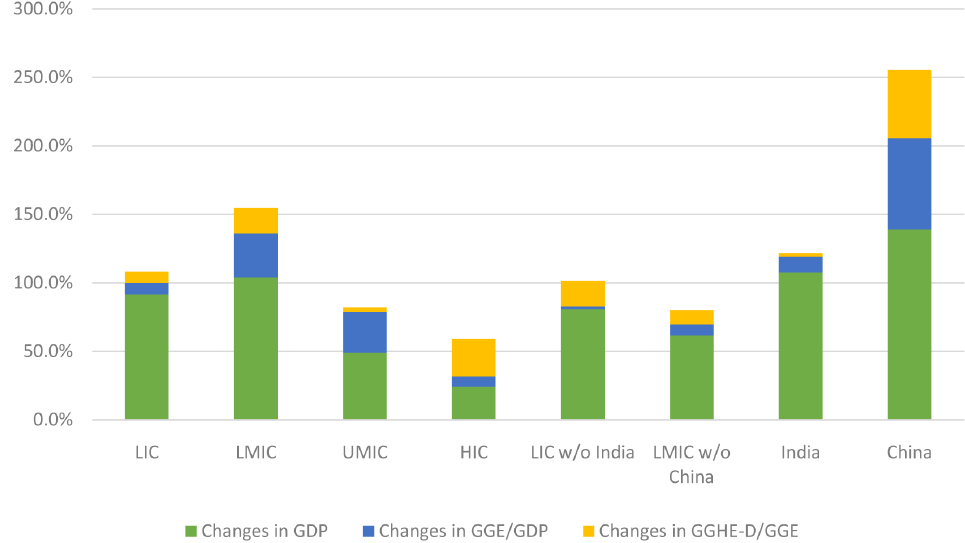
Figure 6. Decomposing increase in domestic general government expenditure on health (GGHE-D) from gross domestic product (GDP) growth, expansion in general government expenditure GGE/GDP, and reallocation of GGE for